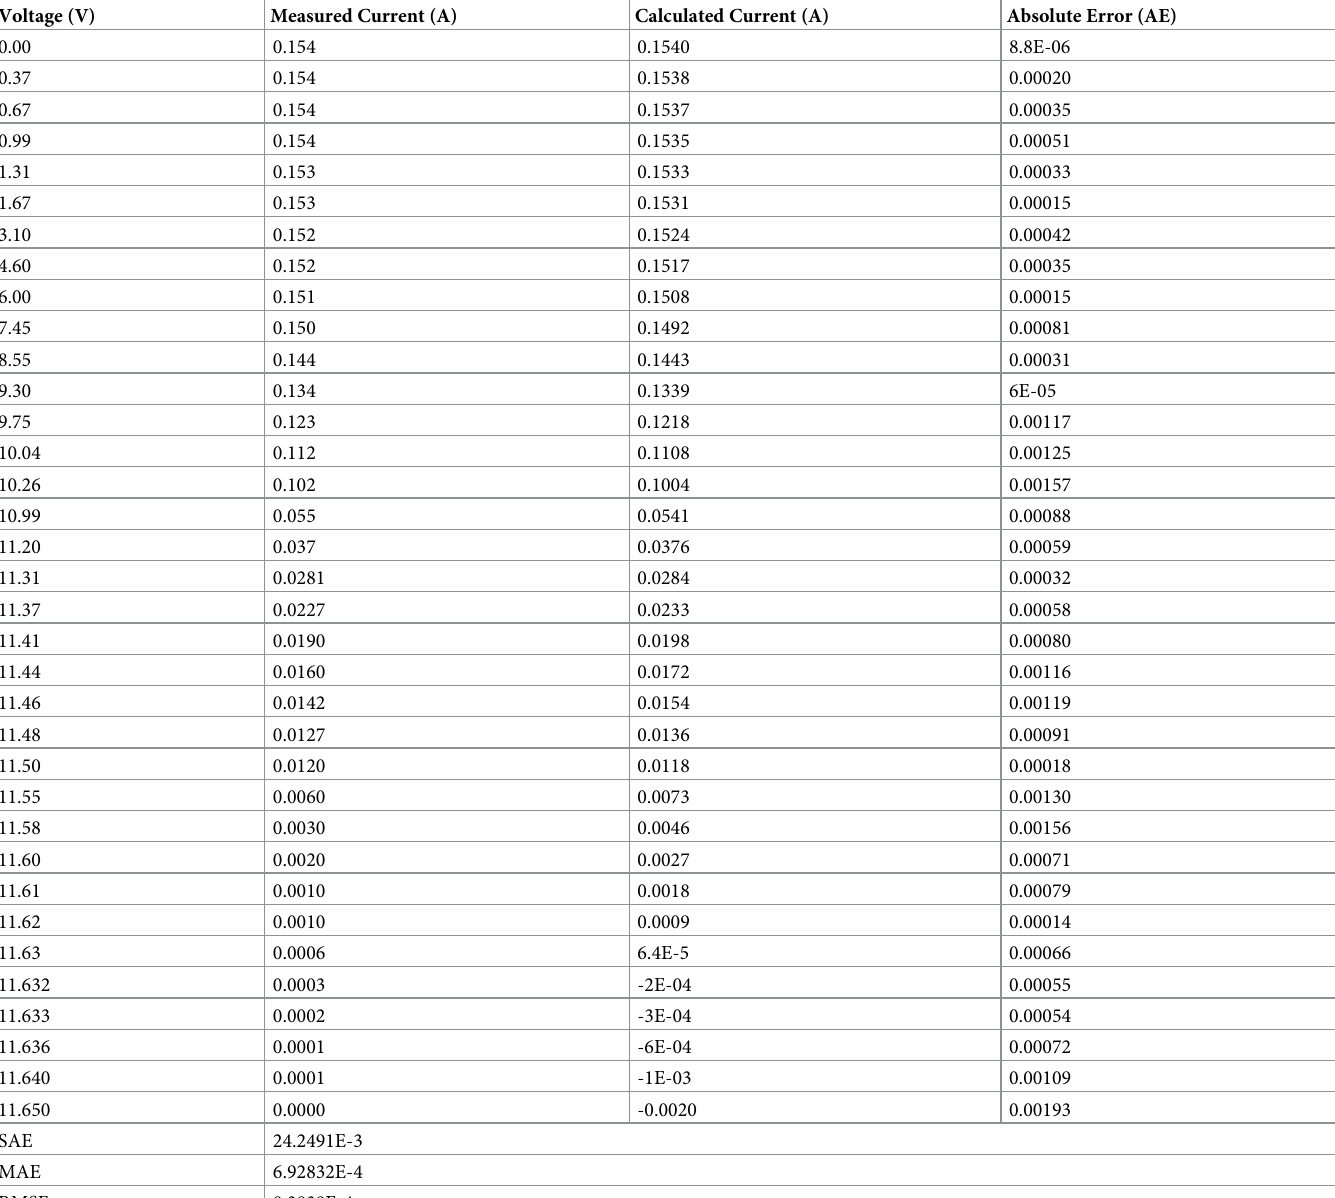
Table 7. ACT simulation-based results for single-diode model of Leibold Solar Module (LSM 20) operated at 24˚C under outdoor sunlight intensity of 360 W/m 2 . Voltage (V) Measured Current